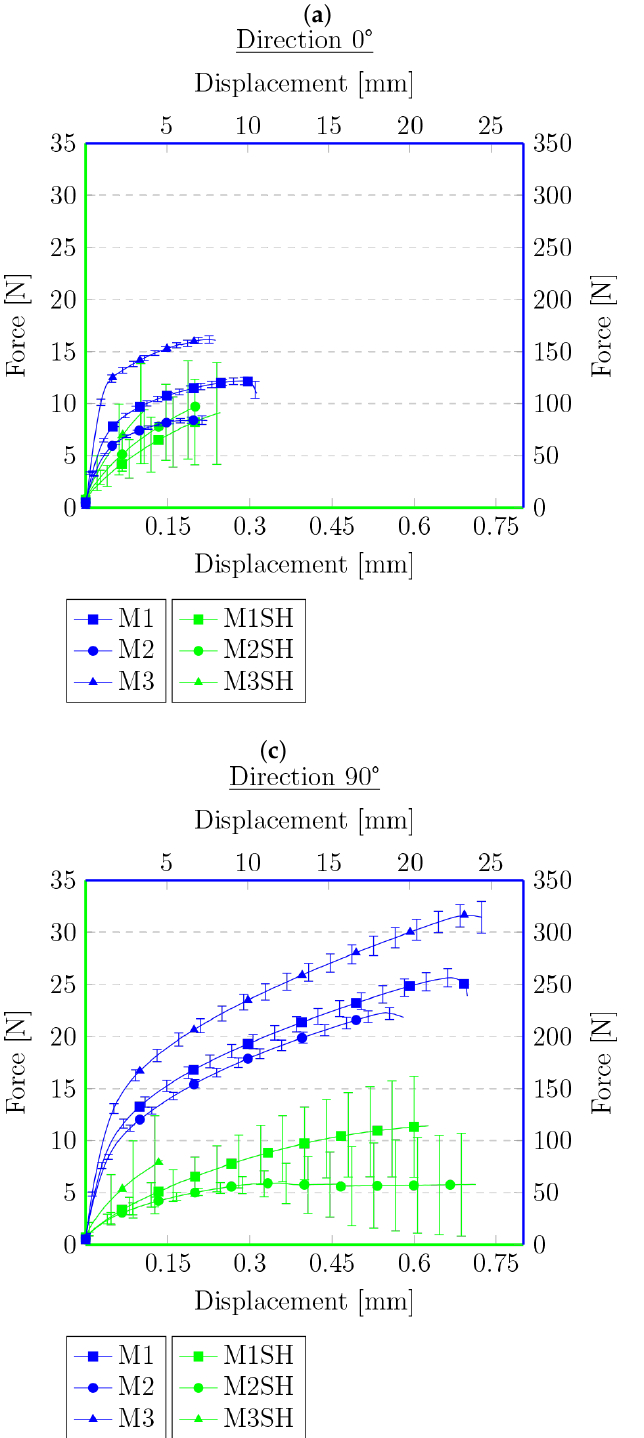
Figure 9. Force–displacement graphs for primary samples (blue) and samples after tensile test and heated (green) with respect to the angle of reinforcement relative to the sample’s longitudinal